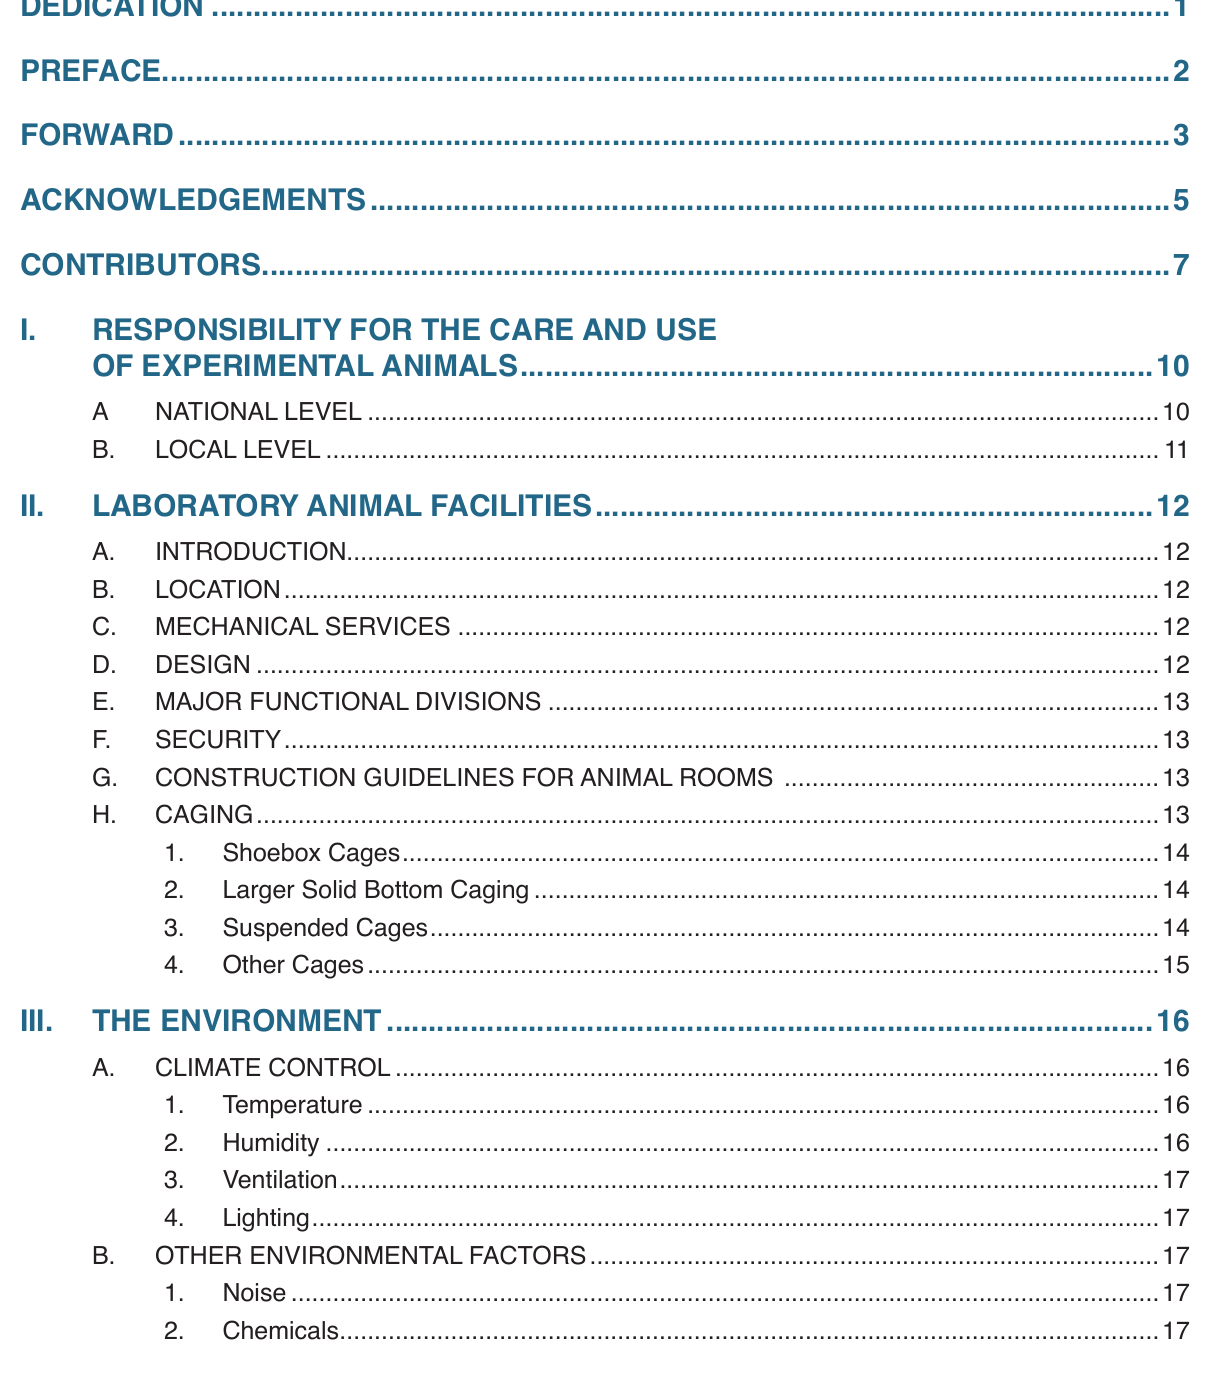
Guide to the Care and Use of Experimental Animals, Volume 1, 2 nd